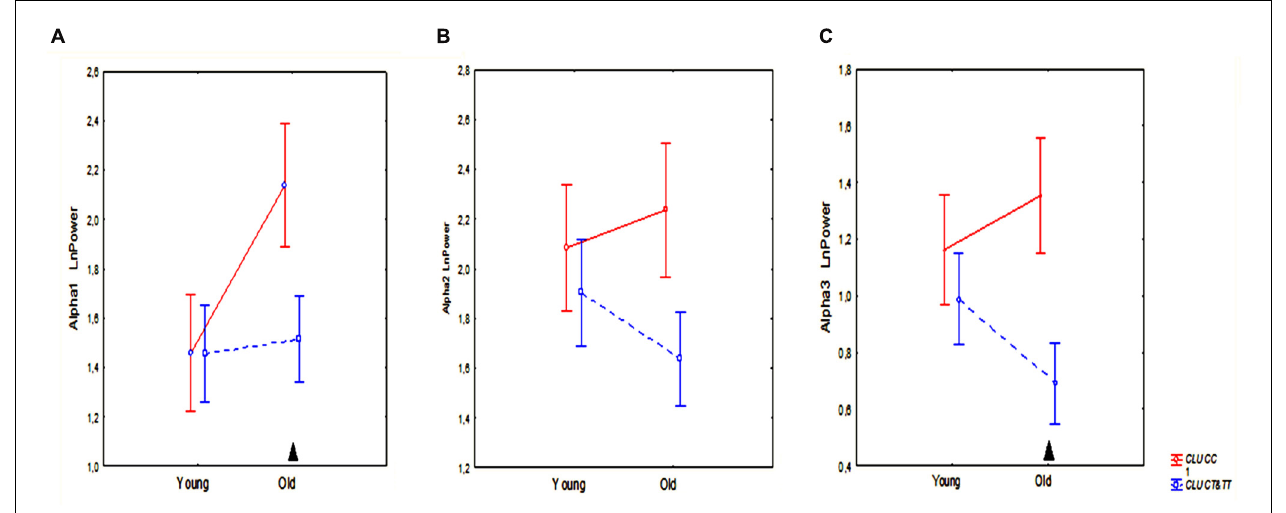
FIGURE 3 |The average absolute power of alpha1 (A), alpha2 (B), and alpha3 (C) bands (mean and SE) in young and old subjects with CLU CC and CLU CT & TT genotypes. Triangle indicates significant differences between the CLU CC and CLU CT & TT carriers P < 0.05.